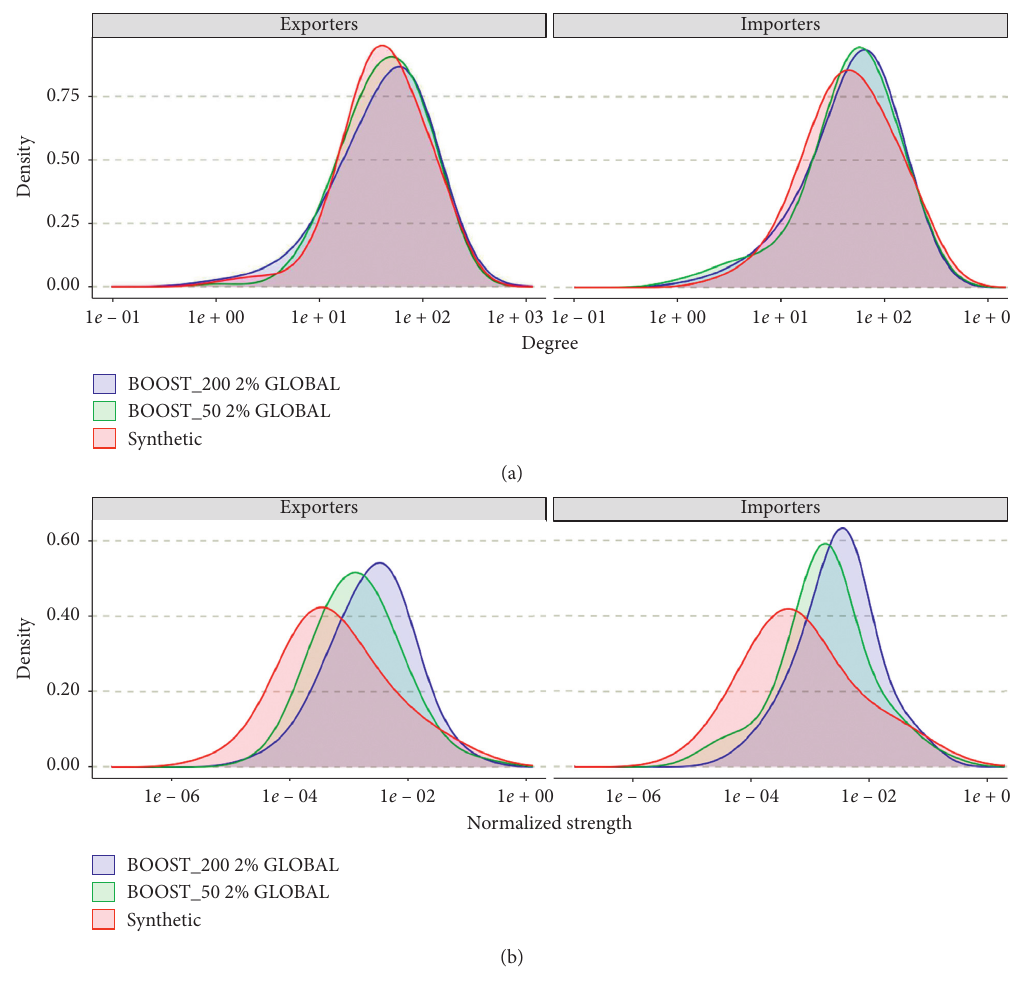
Figure 4: Density distributions for year 2005. (a) Degree. (b) Normalized strength. Plots show the values of the original synthetic ex- periment and two improved networks with probability boost of 50% and 200% for the lower 2% of global trade without regional